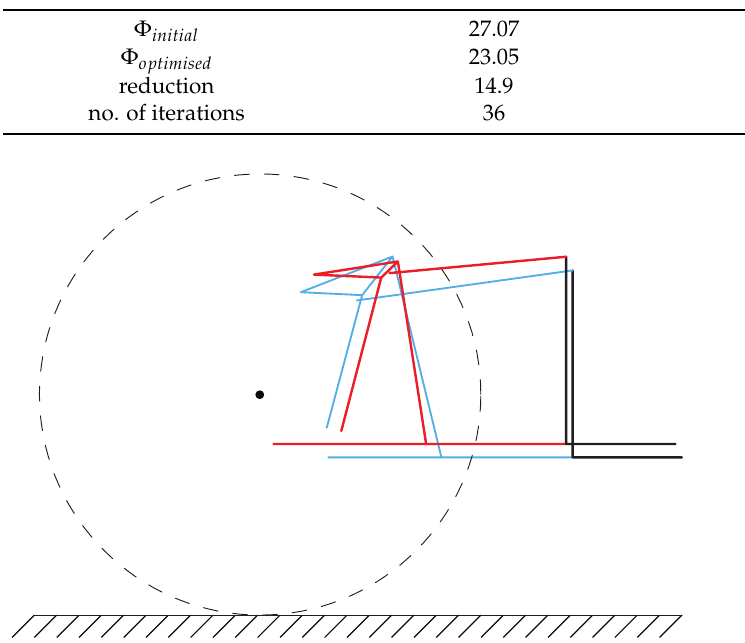
Table 7. Optimiser performance.